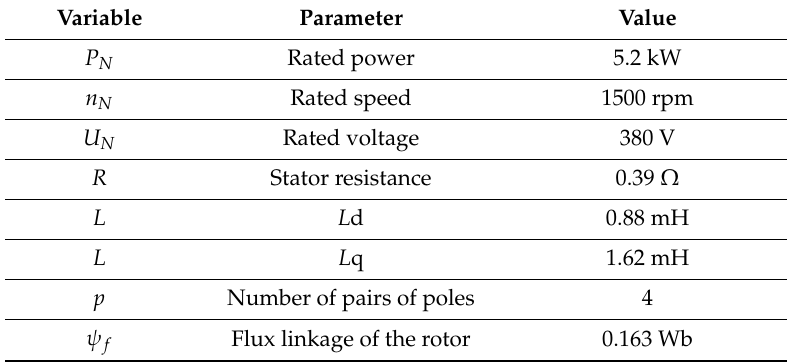
Table 4. Interior permanent magnet synchronous motor (IPMSM) parameters for simulation.